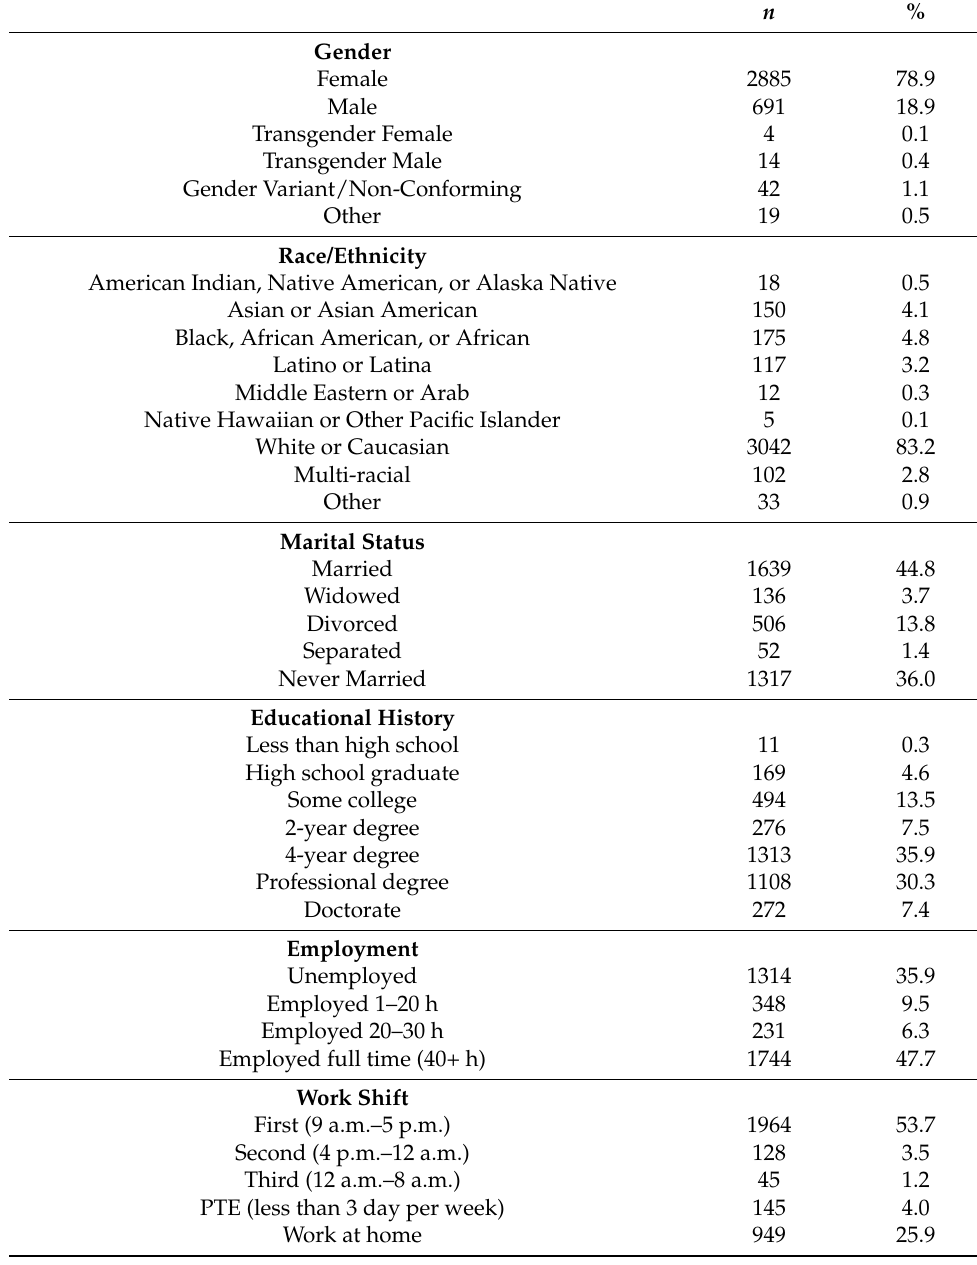
Table 1. Percentages and sample size for all demographic